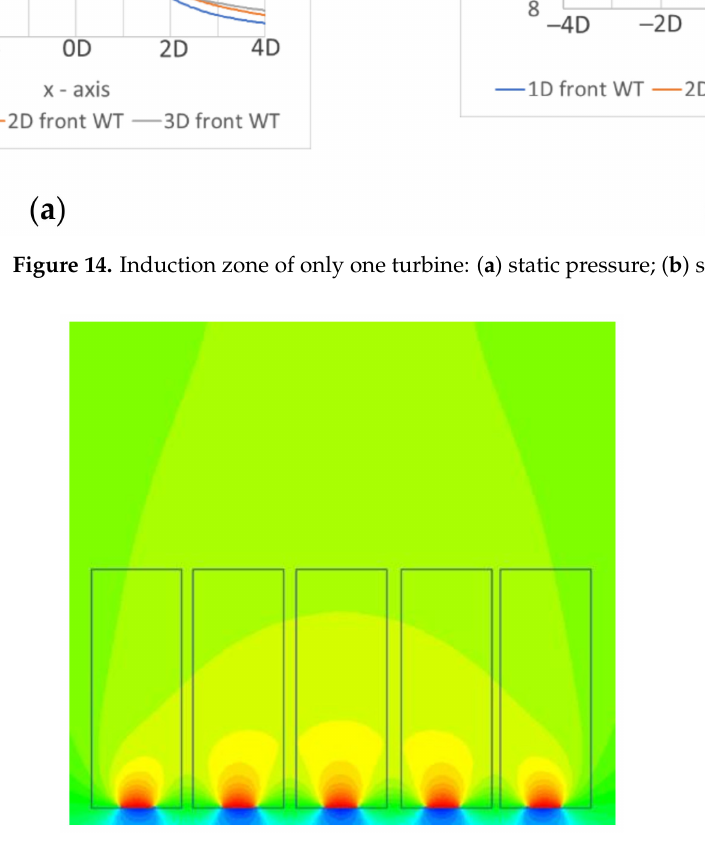
Figure 15. The pressure distribution and control volume around wind turbines from a row.